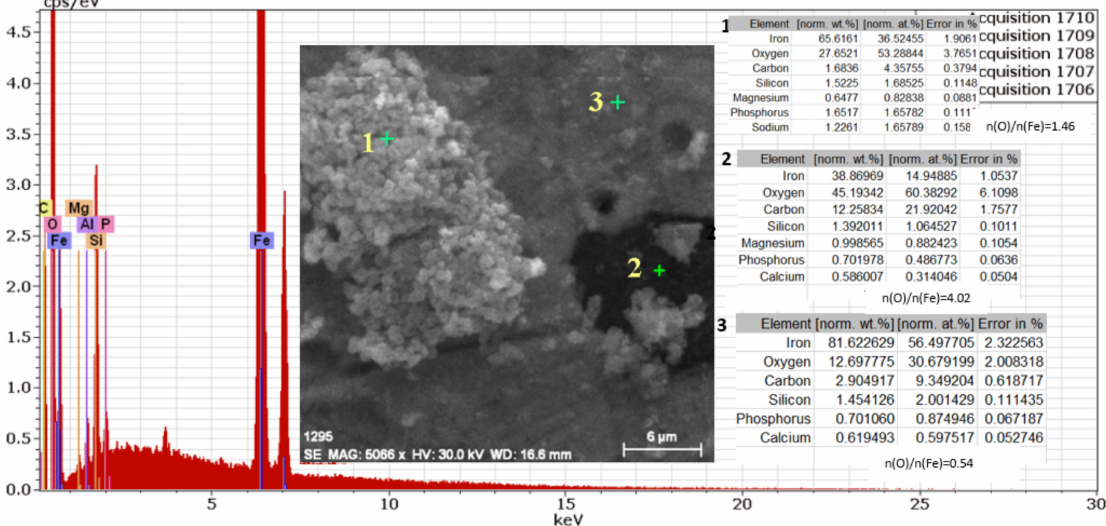
Figure 21. EDS, corrosion zone B, and point compositions on the nodular cast iron surface immersed for 65 days in DWW-3.